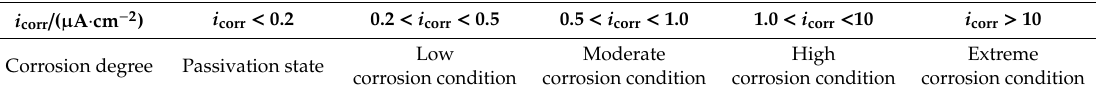
Table 4. Relationship between corrosion current density (i corr ) and corrosion degree of steel. i corr / ( µ A · cm − 2